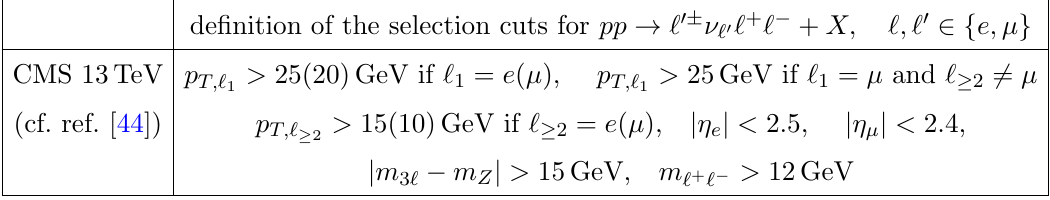
Table 5 . Selection cuts used in our new-physics analysis. ‘ and ‘ 0 refer to all charged leptons, and numbers in indices refer to p T -ordered particles of the respective